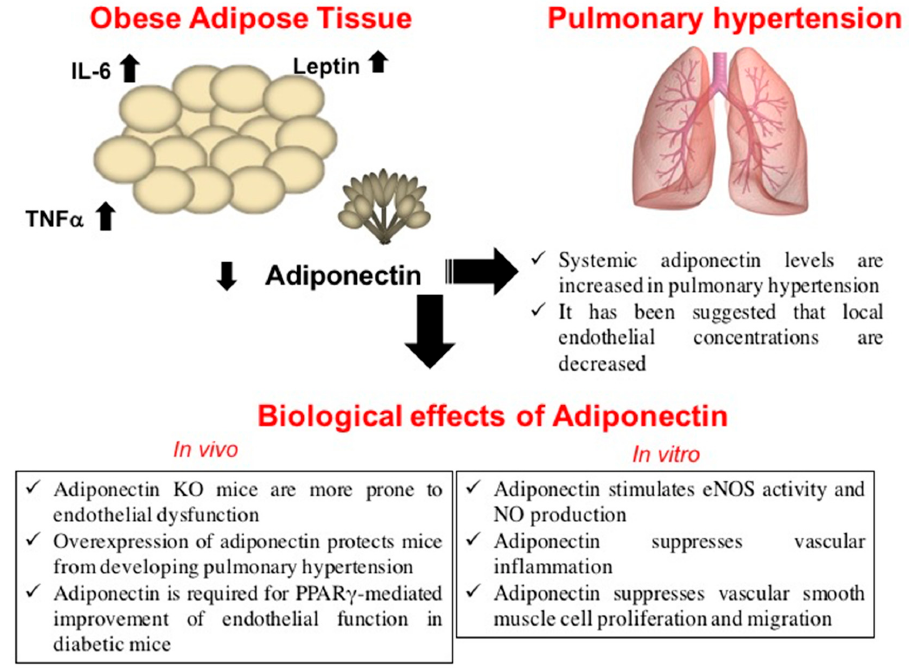
Figure 2. Effects of adipose-tissue hormones on endothelial cell homeostasis. eNOS: endothelial Nitric Oxide Synthase, IL-6: Interleukin-6, KO: knockout, NO: Nitric Oxide), PPAR γ : Peroxisome Proliferator-Activated Receptor gamma, TNF- α : Tumor Necrosis Factor- α